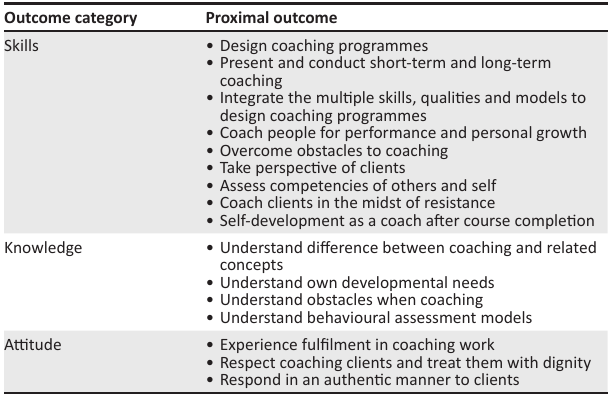
FIGURE 1: Impact model of coach training programme. TABLE 1: Proximal outcomes of coach training